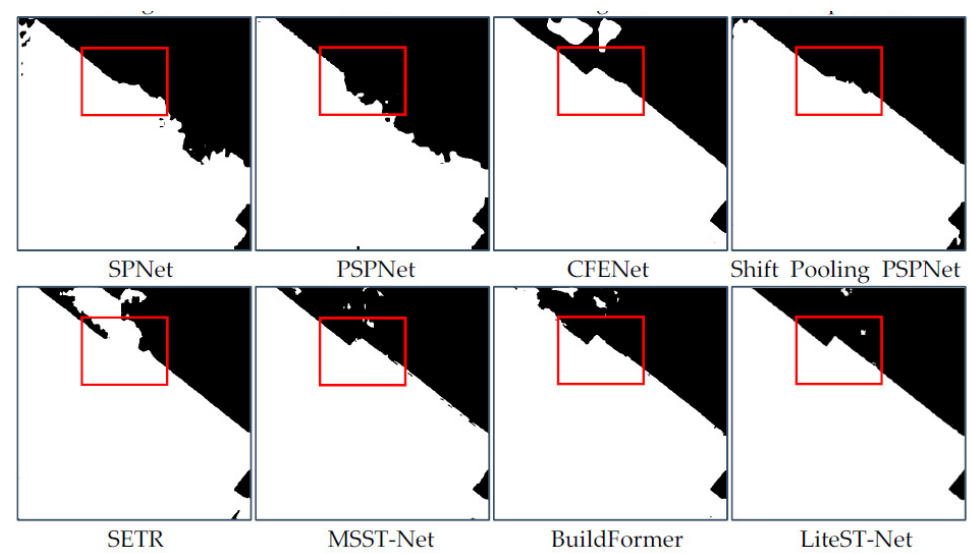
Figure 5. Prediction of classic networks for large buildings on the WHU building test dataset. The red box shows the predicted results of various models for the same large building.